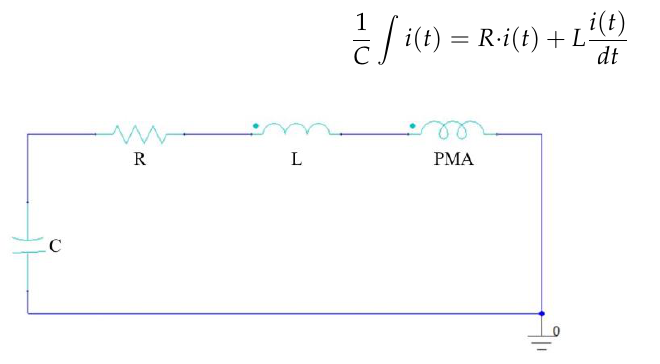
Figure 5. Equivalent circuit.